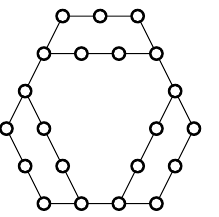
Figure 1: A 2-connected graph with pc ( G ) =